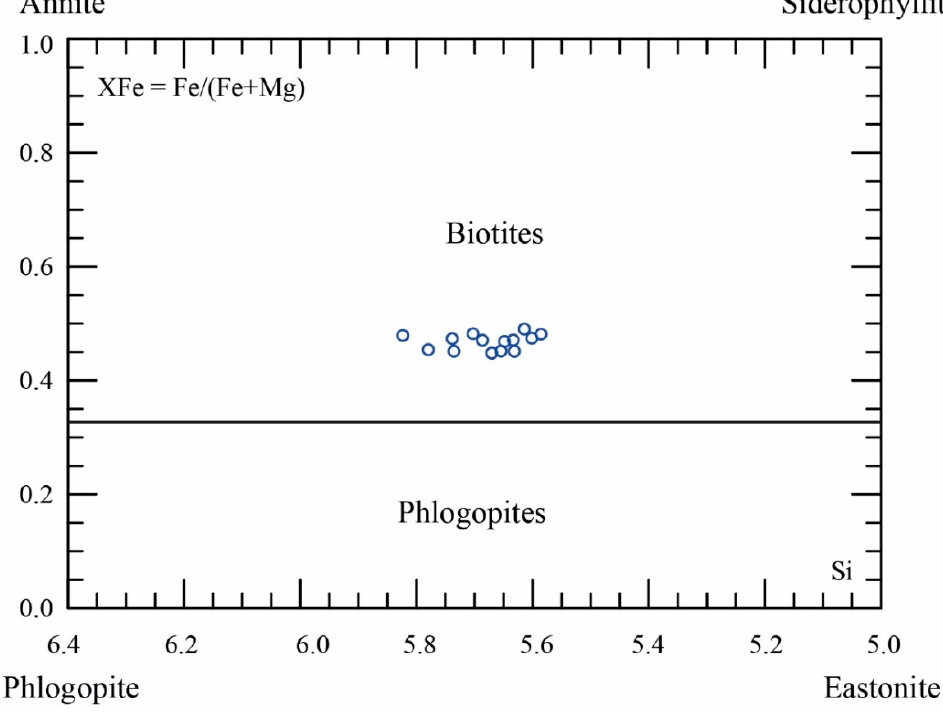
Figure 7. Biotite’s compositional domain of the TSESDAI rhyolitic dome in the Fe/Fe + Mg diagram of [48]. Blue circles indicate the analyzed Biotites.